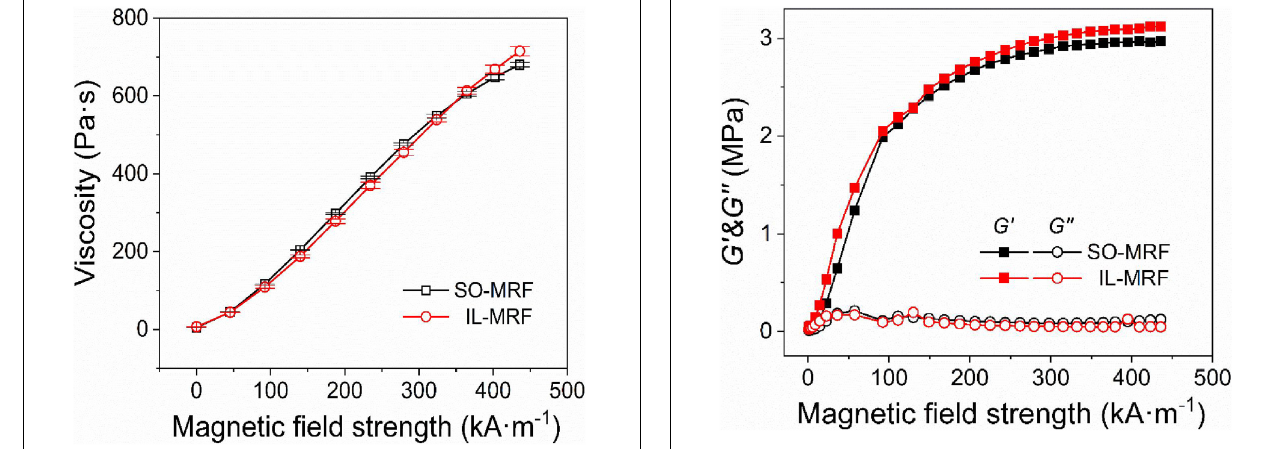
FIGURE 3 | Dependence of viscosity of two MRFs on magnetic field at shear rate of 100 s − 1 .